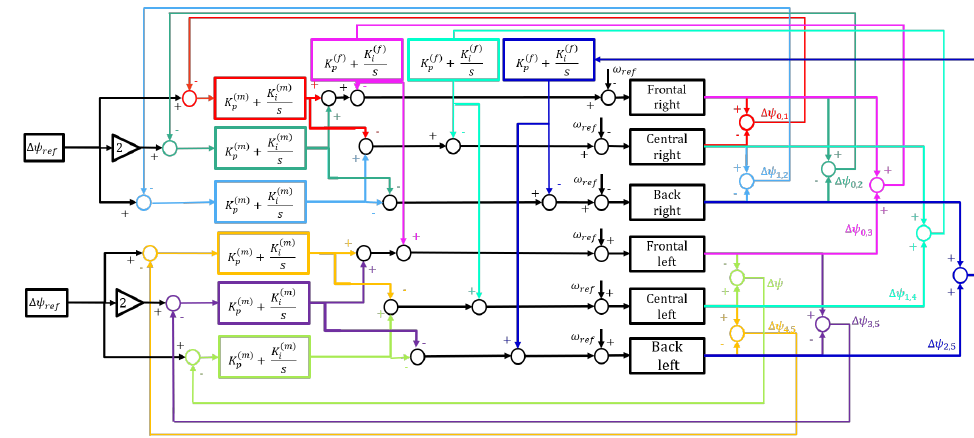
Figure 19. Block diagram of the control algorithm for forward